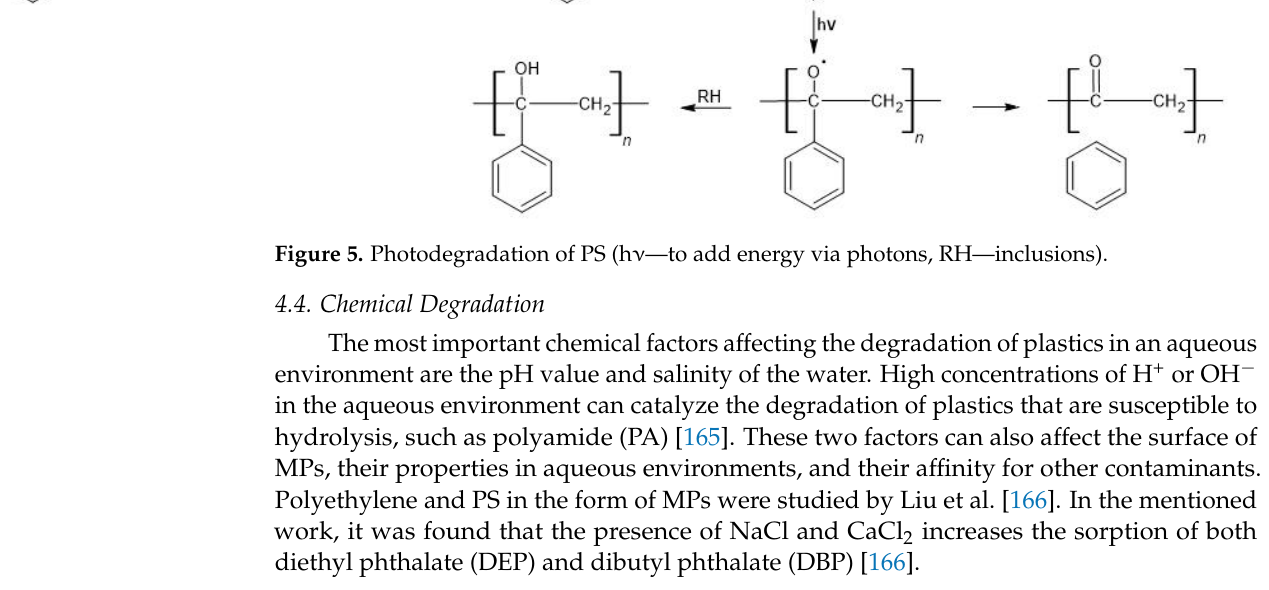
13 of 33 Figure 4. Photodegradation of PET (hν — to add energy via photons, RH —inclusions). Polystyrene Polystyrene is susceptible to photodegradation due to the presence of phenyl rings, which under UV radiation (20 0–300 nm), become excited and form a triplet state. As a result of UV absorption, the following changes are observed: main chain breakage, hydro- gen atom stripping, and phenyl ring stripping. During the degradation process, macro- radicals are formed, which in the next step, undergo oxidation in the presence of atmos- pheric oxygen, with the formation of superoxide radicals. Subsequent reactions lead to the formation of hydroperoxi de, hydroxyl, and carboxyl groups. Eventually, chain scis- sion occurs, forming carbonyl compounds, benzene, styrene, and olefin (Figure 5) [163,164 ]. In summary, polystyrene MPs can be formed by photodegradation. These par-